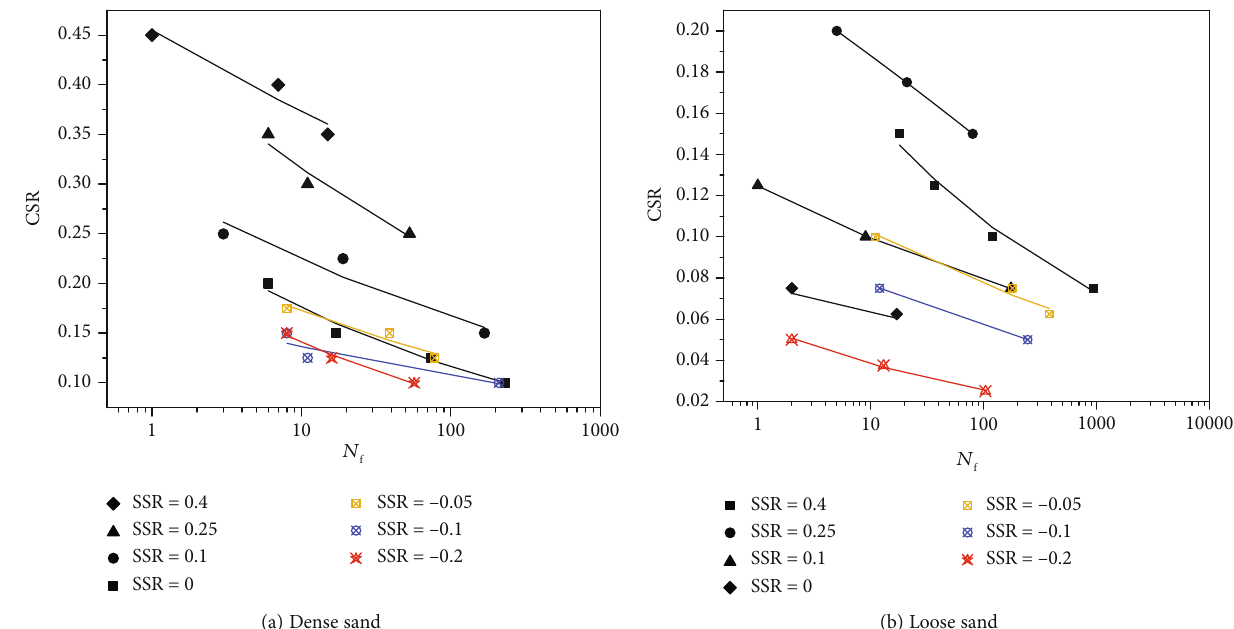
Figure 8: Relationship between CSR and N